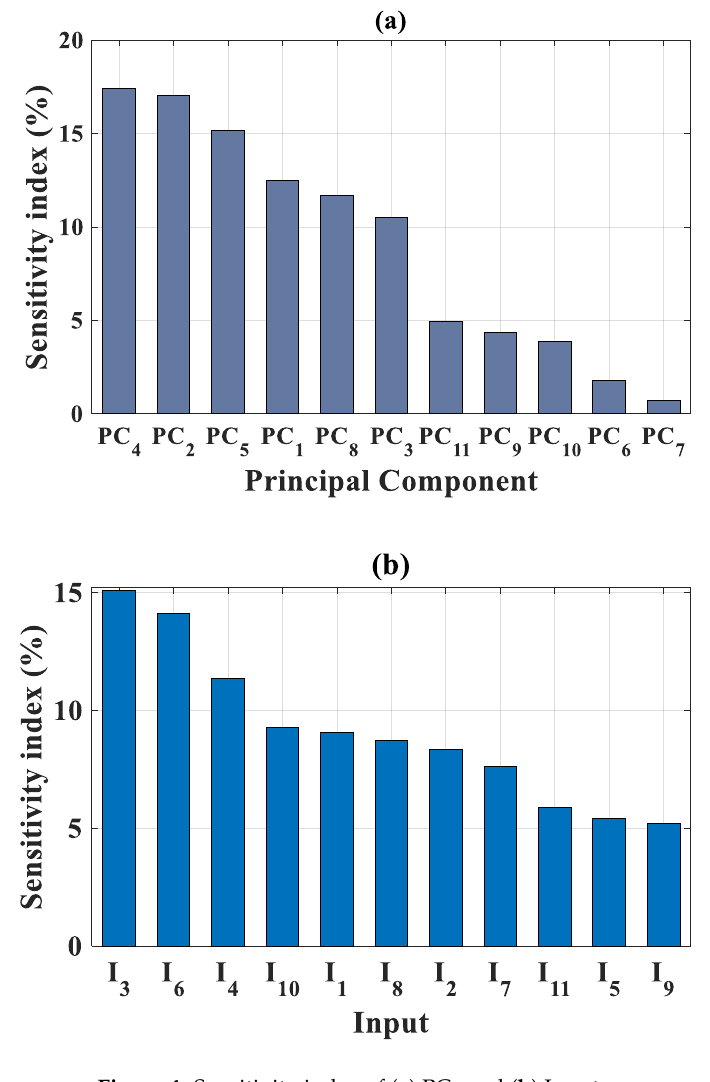
Figure 4. Sensitivity index of ( a ) PCs and ( b ) Inputs.